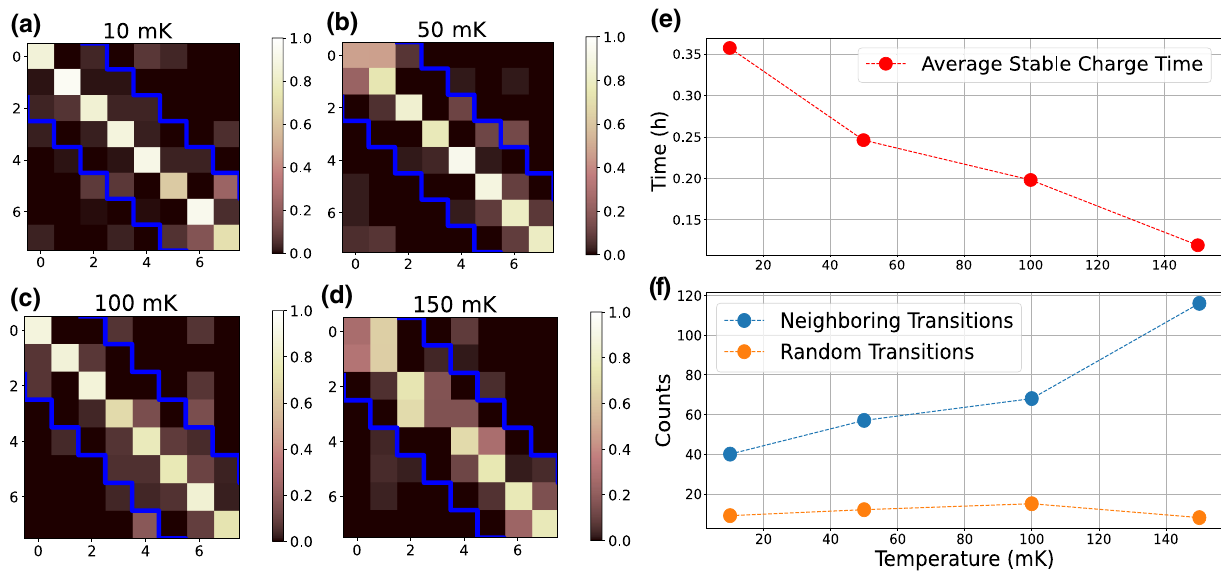
FIG. 5. Transition matrices between quasistable charge configurations at various temperatures. A HMM is employed to identify the finite number of quasistable charge configurations consistently across temperatures. (a)–(d). The diagonal elements of the matrices represent the probability for the charge environment to remain in that same configuration. The off-diagonal elements represent the probability for the charge environment to transition between configurations. The region denoting nearest and next-nearest neighbor transitions are outlined in blue. For each temperature, the majority of transitions happen between adjacent charge configurations. (e). Shown are the average stable charge times for each temperature. They show a decrease in stable charge time with increasing temperature. (f). The transitions can be neatly divided into nearest and next-nearest neighbor hopping and the remaining transitions. The nearest and next-nearest hopping shows an increasing dependence on temperature while the remaining transitions are temperature independent. Each temperature data set is taken over approximately 16